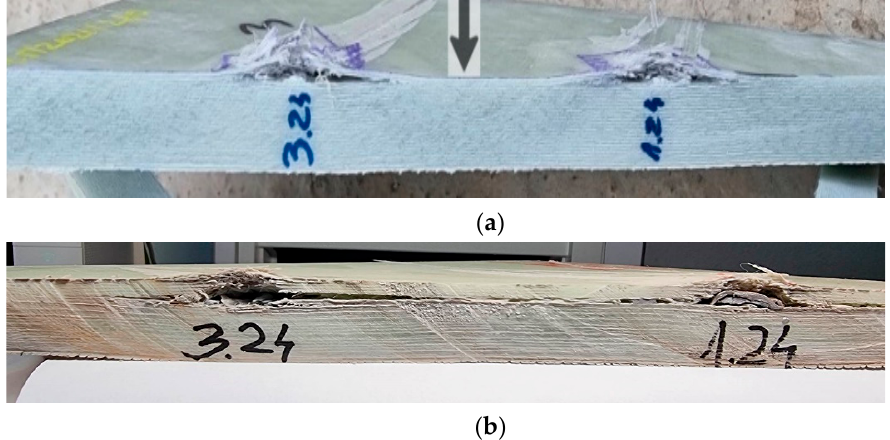
Figure 10. Cross-sections of lines with two fires: fire 1 (1.24) and fire 3 (3.24) for ( a ) 9 mm FMJ, fire 1 (coded 1.24) and fire 3 (coded 3.24) and ( b ) .357 Magnum fire 1 (coded 1.24) and fire 3 (coded 3.24).